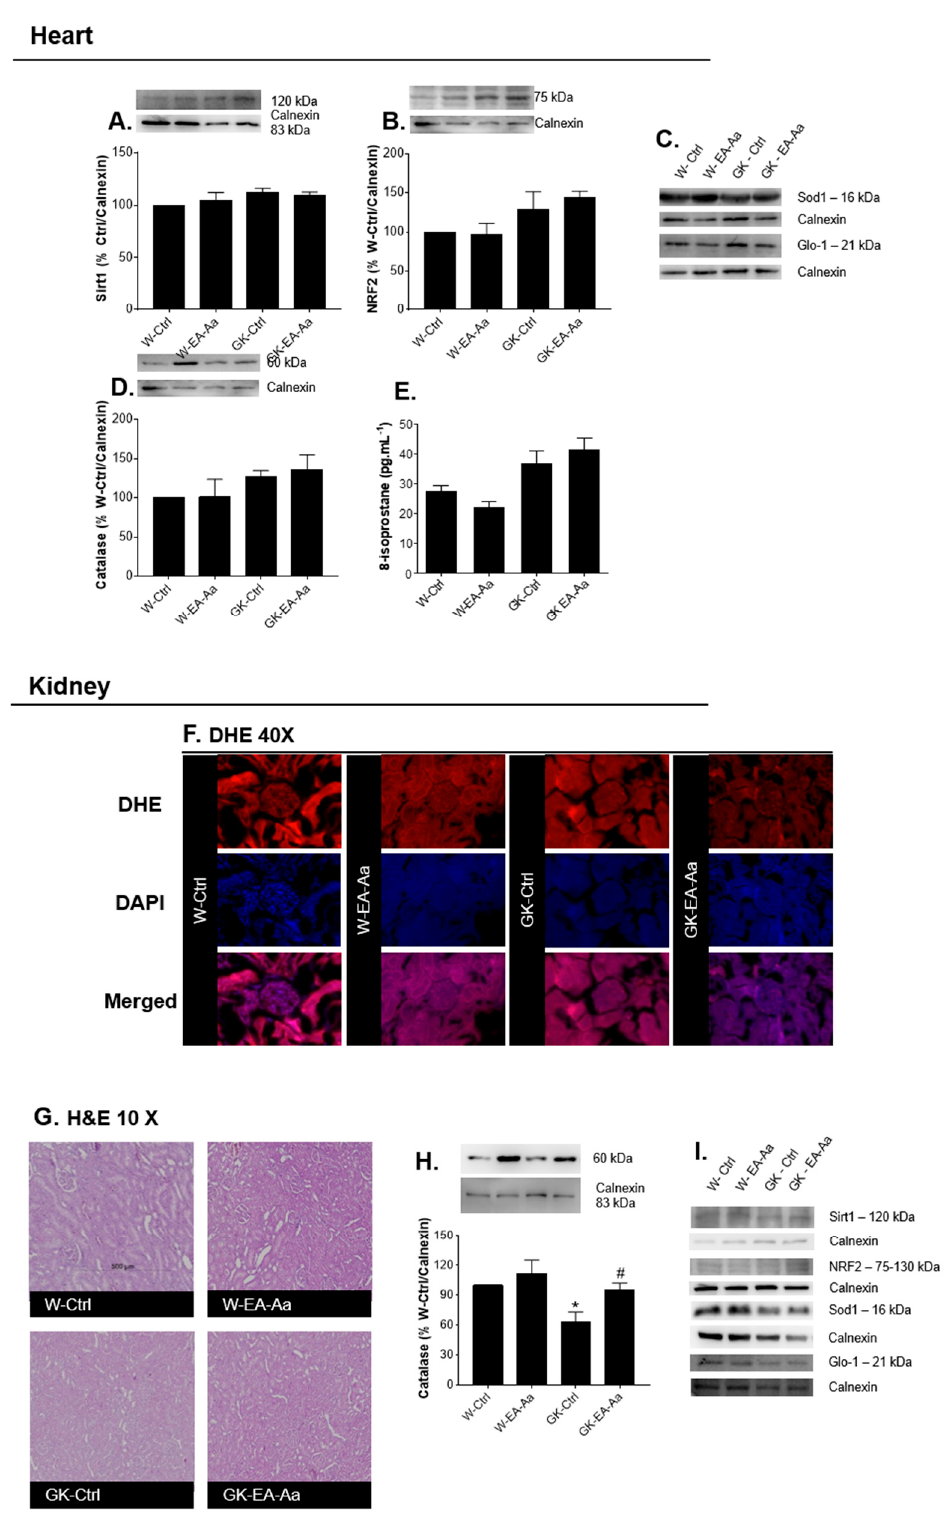
Figure 4. Levels of stress-related proteins in target organs of redox imbalance, heart and kidney. ( A ) Sirt1 levels in heart. ( B ) NRF2 levels in heart. ( C ) Representative images of heart Western blot. ( D ) Catalase levels in heart ( n = 5 for Western blots). ( E ) Heart 8-isoprostane levels ( n = 5–7). ( F ) DHE staining in kidney ( n = 3). ( G ) Haematoxylin-eosin staining in kidney. ( H ) Catalase levels in kidney; a restoration is evident is GK-EA-Aa in relation to GK-Ctrl group. ( I ) Representative images of kidney Western blot. * vs. W-Ctrl/Ctrl; # vs. H 2 O 2 ; *,# p < 0.05.